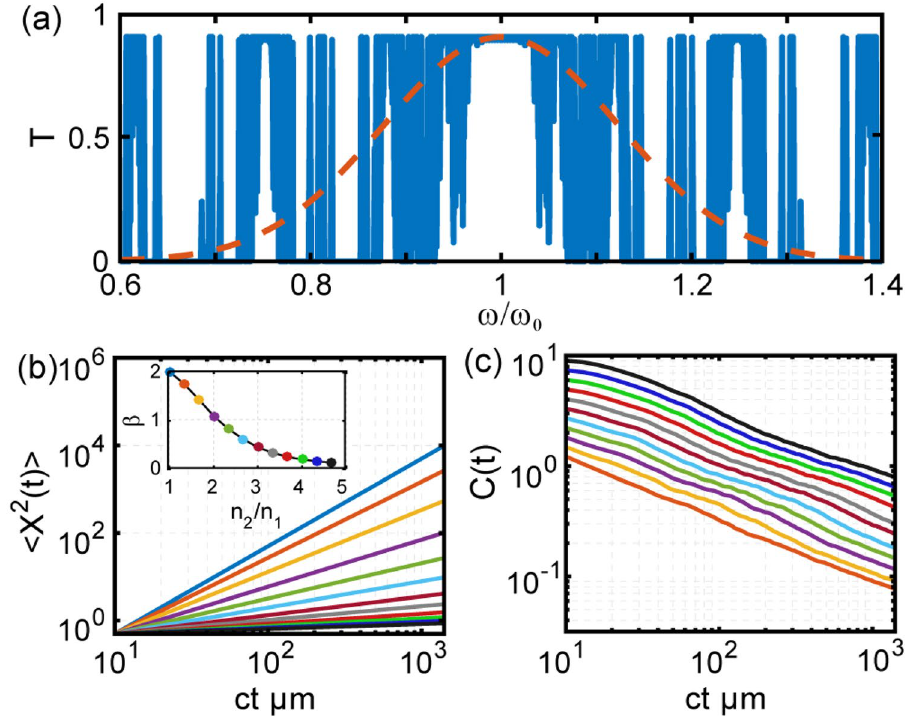
Figure 4. ( a ) Representative transmission spectrum of a Thue-Morse multilayer with refractive indices n 1 = 1.5 and n 2 = 1.9 with layer thickness λ 0 /4 n 1 and λ 0 /4 n 2 respectively. Dashed line represents the frequency spectrum of the incident optical pulse with central wavelength at 1550 nm. ( b ) Computed MSD values as a function of time and refractive index contrast between the constituent layers ( n 1 = 1.5 in all cases), Inset shows the scaling exponent of the MSD obtained using numerical fitting of the data to power law. The quality of the fitting is demonstrated with representative dashed lines overlapping the data in main panel. ( c ) Computed ACF as function of time. Inset shows the scaling exponent of the ACF obtained using numerical fitting of the data to power law. ‘ct’ in ( b ) and ( c ) is the time equivalent length where c represents the velocity of light in vacuum and t represents